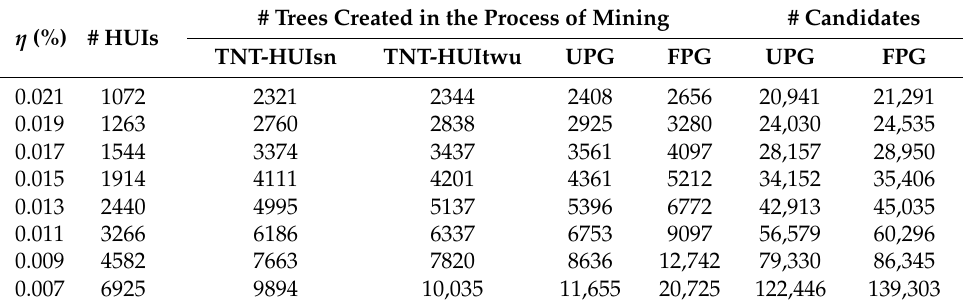
Table 10. Details analysis on the dataset